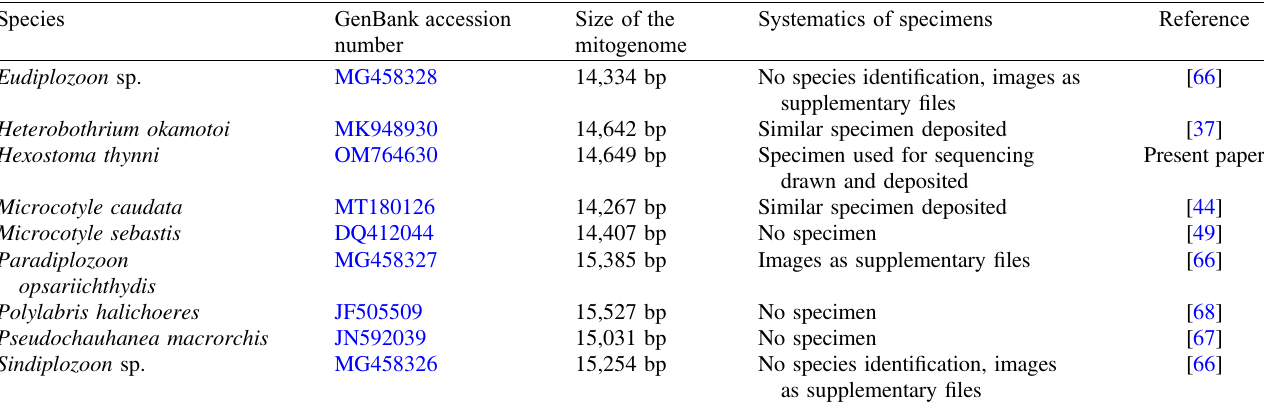
Table 3. Mitogenomes of polyopisthocotylean monogeneans. The table indicates the size of the mitogenomes and the precautions taken by authors to ascertain the systematics of the specimens they used.